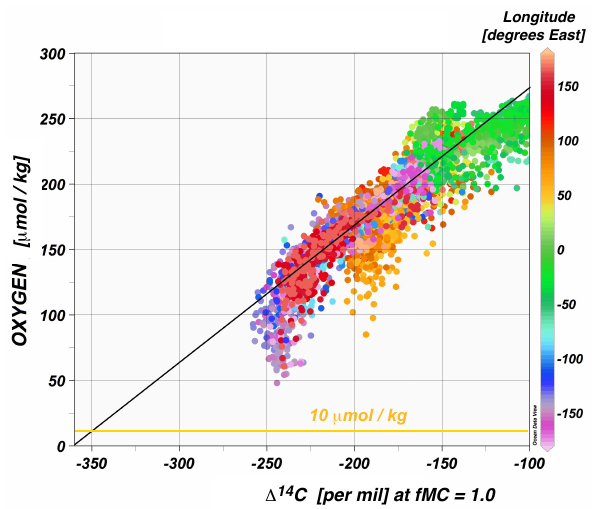
Fig. 5. Ratio of total dissolved oxygen (µmolkg − 1 ) vs. 1 14 C (equivalent to deep-water ventilation age) in the modern ocean be- low >2000mw.d. Positive O 2 “bump” at − 140 to − 170 per mil 1 14 C reflects the advection of freshly ventilated Weddell Sea wa- ters. The regression line (average slope: 1.16µmolkg − 1 per ‰ 1 14 C) depicts the maximum O 2 averaged for each per mil of deep-water 1 14 C, that is for organic carbon flux rates below low- productivity regions. The line is extrapolated down to − 360‰ 1 14 C for the maximum LGM deep-water age of 3600yr shown in Fig. 7a. Enhanced O 2 depletion at − 175 to − 200 and − 225 to − 250‰ 1 14 C reflects increased flux rates of organic carbon below high productivity zones in the northern Indian and Pacific oceans